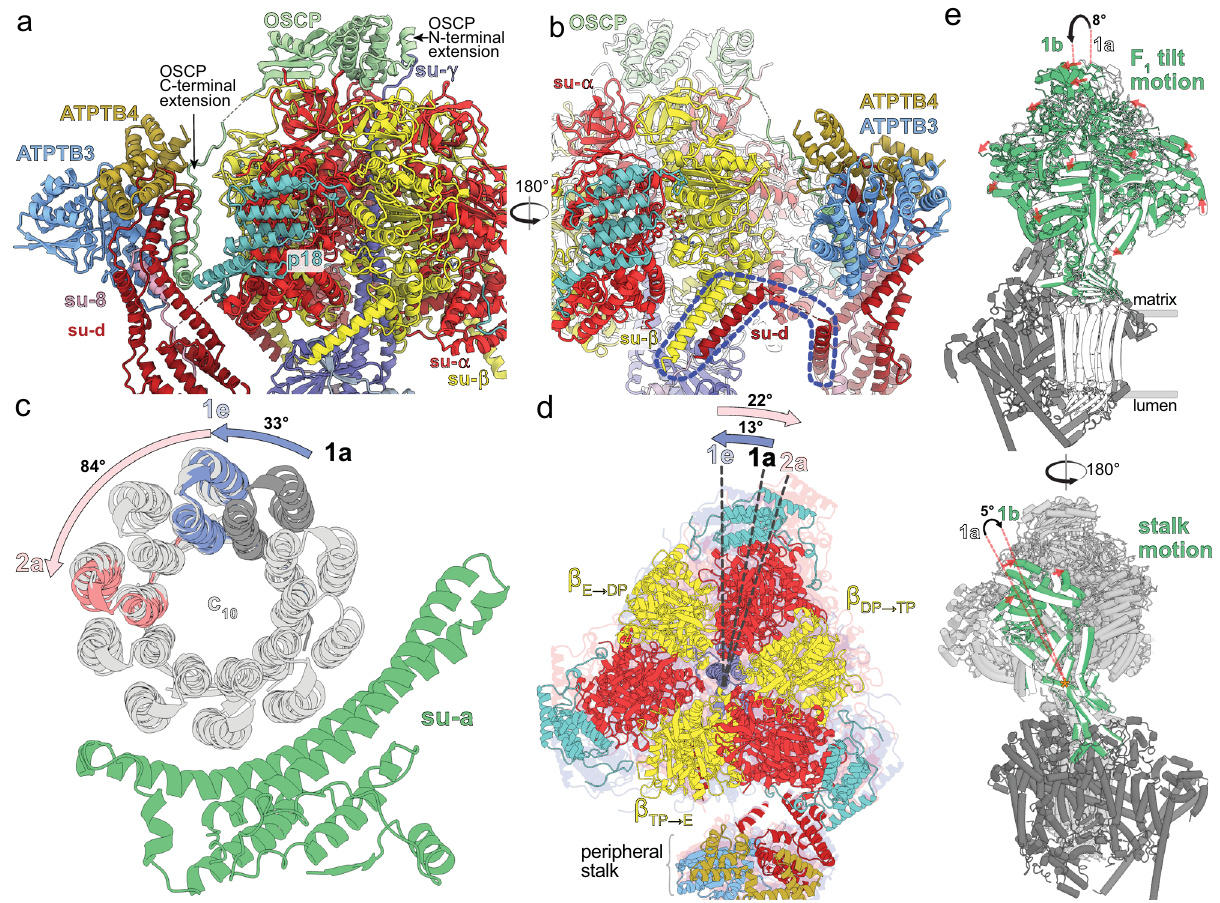
Fig. 3 | A divergent peripheral stalk allows high fl exibility during rotary cata-